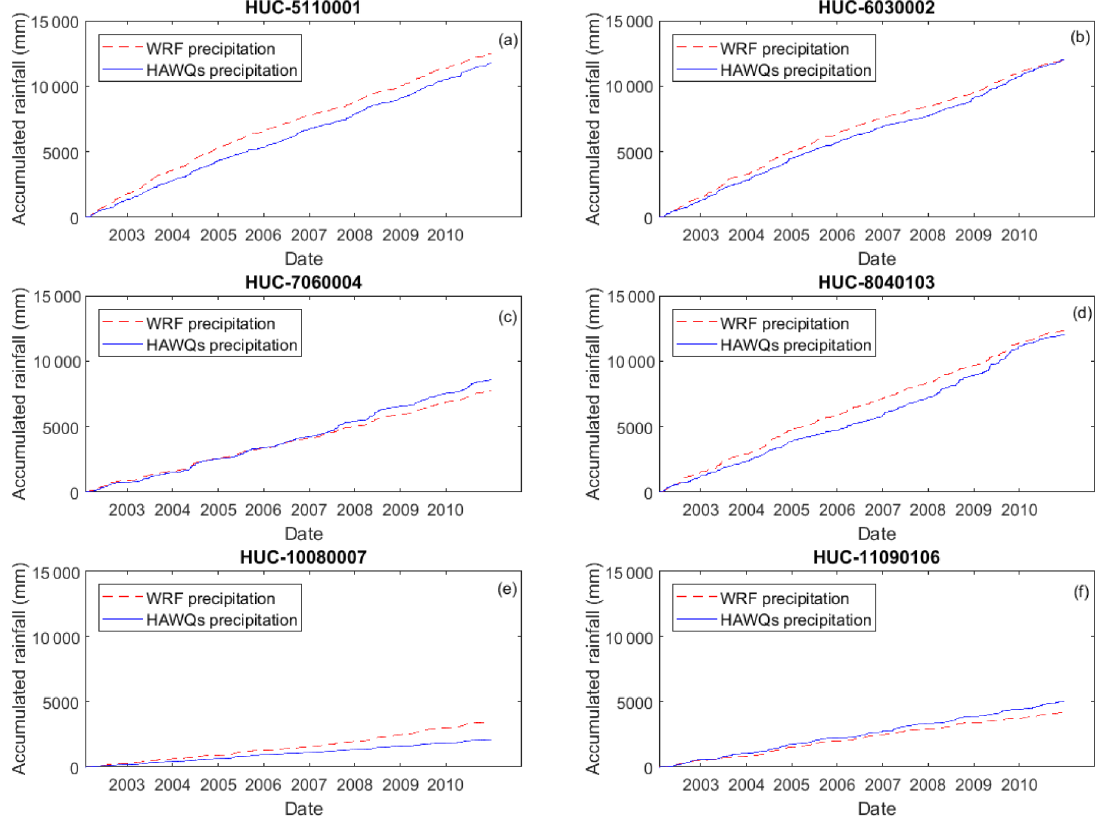
Figure 4. Rainfall accumulation curve comparison between NOAA-NCEI for HAWQS and WRF climate at randomly selected 8-digit HUCs: (a) Ohio River basin, (b) Tennessee River basin, (c) upper Mississippi River basin, (d) lower Mississippi River basin, (e) Missouri River basin, and (f) Arkansas Red–White River